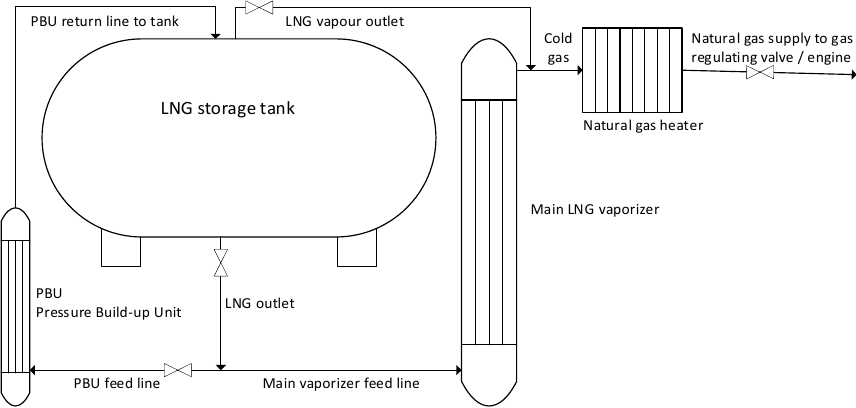
(<10 bar) LNG storage tank, main vaporizer, gas heater and pressure build-up unit (PBU). An